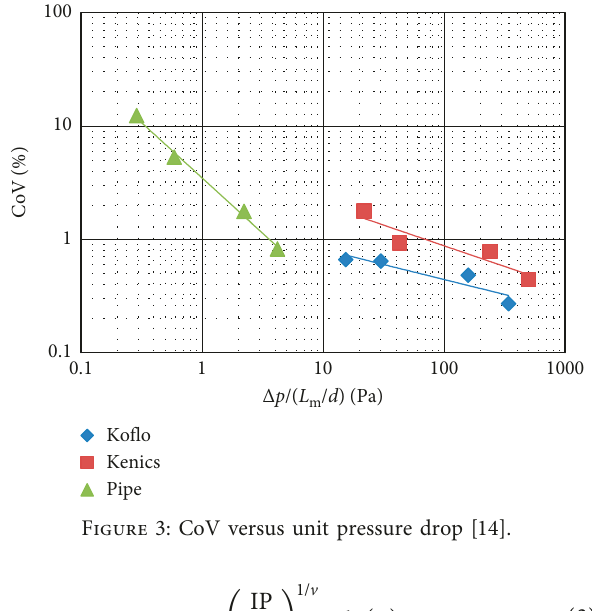
Figure 3: CoV versus unit pressure drop